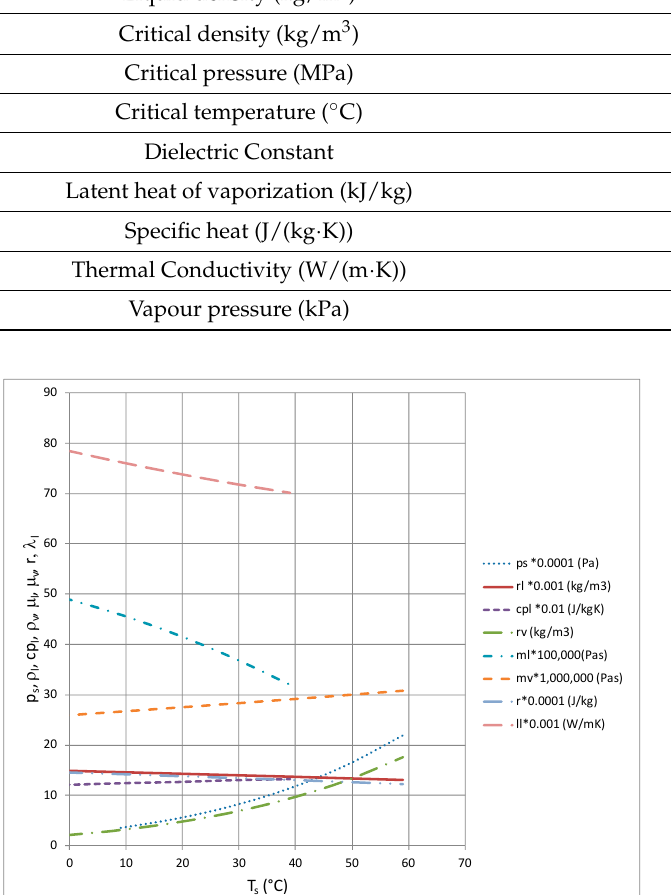
Figure 4. Example properties of HFE 7000 refrigerant [16,17]: saturation pressure p s (ps); heat of evaporation r; specific heat of liquid cp l (cpl); heat conductivity of liquid λ l (ll); liquid density ρ l (rl); vapor density ρ v ; (rv); liquid viscosity μ l (ml); and vapor viscosity μ v (mv). Table 1. Physical properties of HFE 7000 refrigerant for working temperature 25 °C [17].